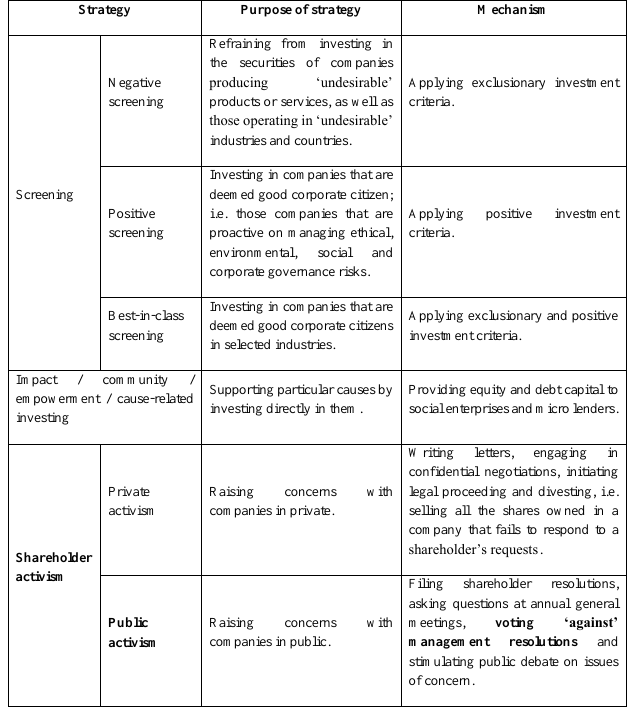
Figure 1: Responsible investment strategies Source: Adapted from Nordén & Strand (2011); Morgan, Poulsen, Wolf & Yang (2011); Cheng, Huang, Li & Lobo (2010); Judge, Guar & Muller-Kahle (2010); Admati & Pfleiderer (2009); Kaempfer, Lehman & Lowenberg